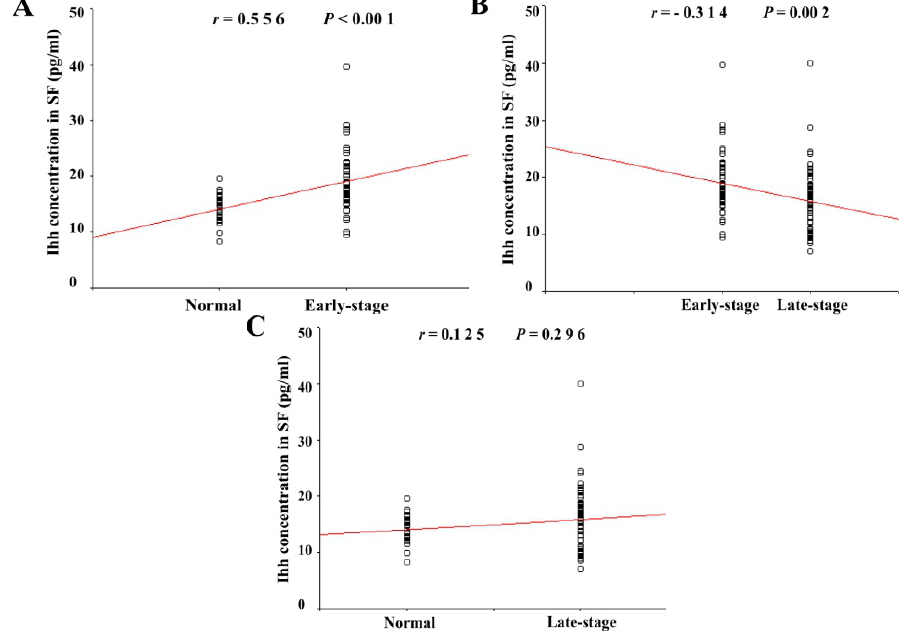
detected by Ihh probe was found 7 days after partial medial meniscectomy (PMM) surgery in the right knee but not in the left control knee (Figure 7, right two mice, n = 5). Figure 5. The increase of Ihh concentration in synovial fluid (SF) was correlated to the early stage of OA cartilage lesions. There was a significant correlation ( r = 0.556; p < 0.001) between the Ihh concentration in SF and the articular cartilage Outer-bridge score from early stage OA (Outer-bridge 1–2, n = 50) but not in the late stage OA group (Outer-bridge 3–4, n = 47) compared to the normal control (Outer-bridge 0, n = 25). The level of Ihh was decreased in the late stage OA due to the severity cartilage damage. Spearman’s test was used for statistic analysis; p values of less than 0.05 were considered statistically significant.